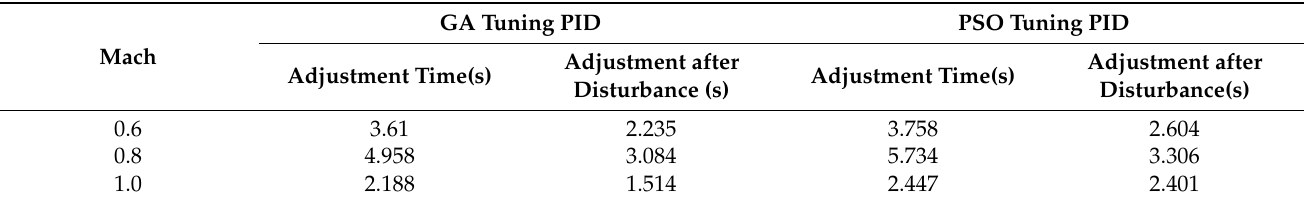
Table 3. Control quality indexes.